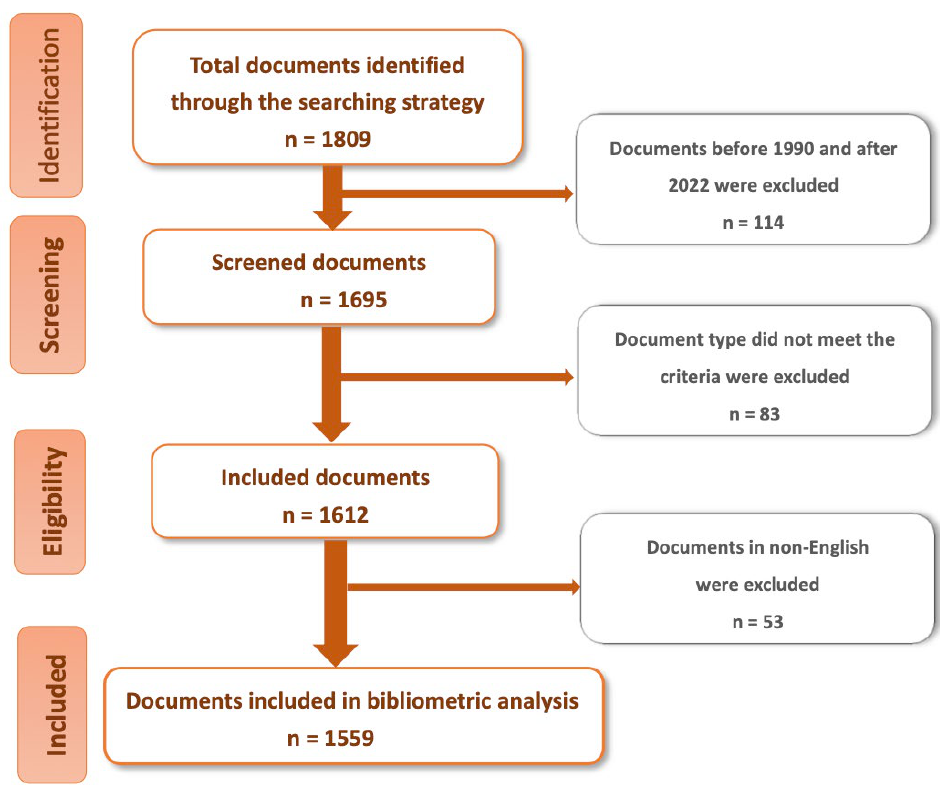
Figure 1. The research flow chart of the bibliometric analysis.